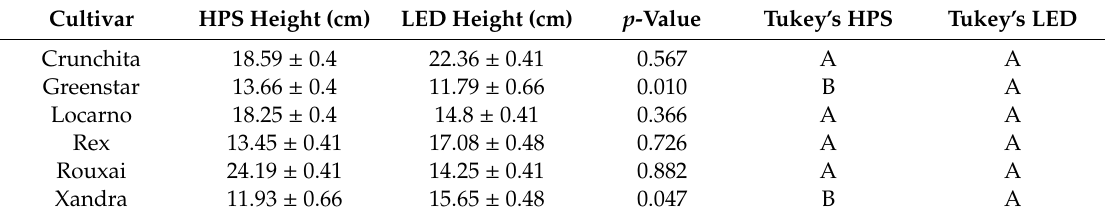
Table 11. Height of the six lettuce cultivars in phase 2 under HPS versus LED greenhouse supplemental lights. Data are means ± standard error (SE) of circa 72 plants from three crop cycles. A t -test was used to compare the FW of HPS versus LED within a cultivar ( p -value) and Tukey’s Honestly Significant Di ff erence at α = 0.05 was used to compare cultivars with the HPS or LED treatment. Cultivar HPS Height (cm) LED Height (cm) p -Value Tukey’s HPS Tukey’s LED Crunchita